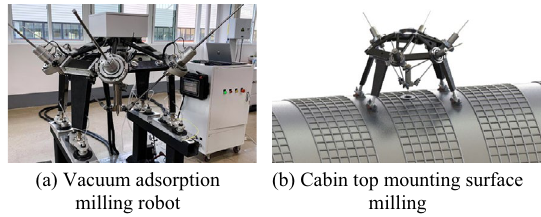
Figure 23 Vacuum adsorption milling robot and its application